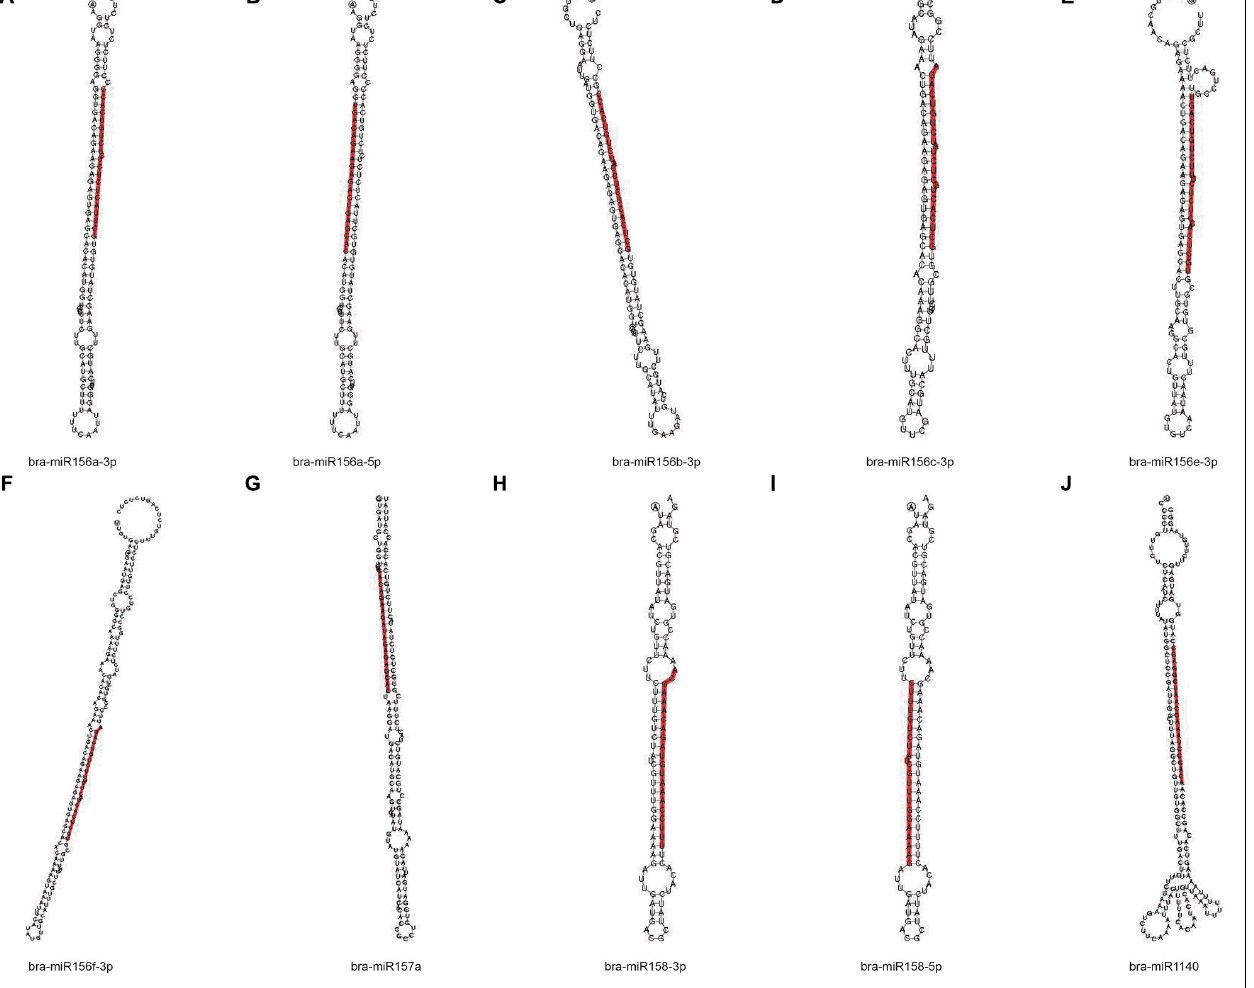
Frontiers in Genetics |